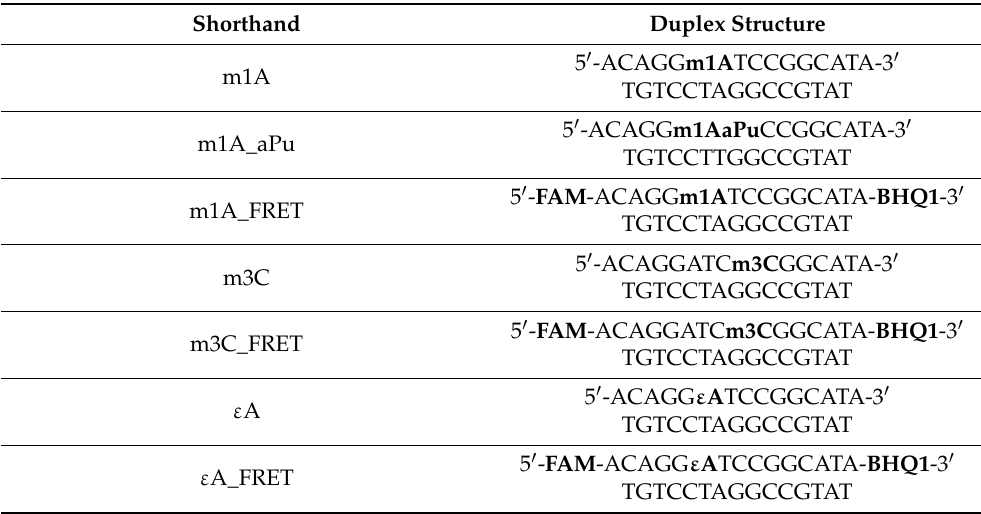
Table 1. The structure of double-stranded oligodeoxyribonucleotides (dsODNs) used as substrates for ALKBH2. m1A: N1-methyladenine; m3C: N3-methylcytosine; ε A: 1,N6-ethenoadenine.